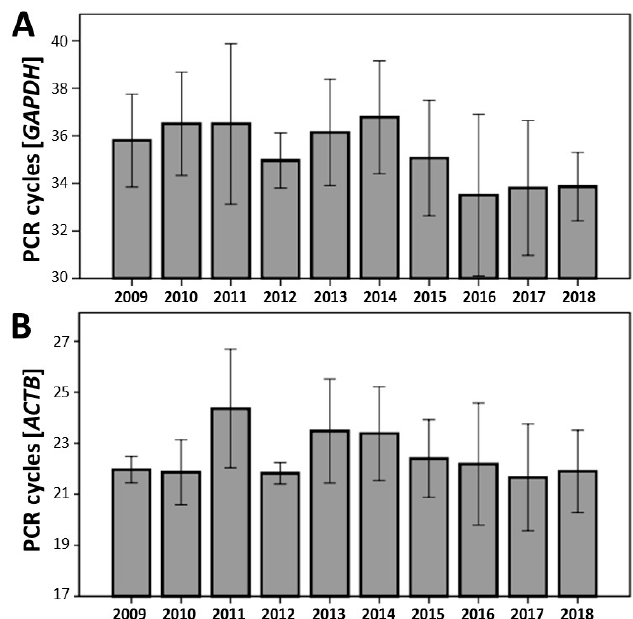
Figure 6. Results of qRT-PCR analysis from FFPE vascular tissue samples from different years between 2009 and 2018 ( n = 5 for each study group) using TaqMan primer for glyceraldehyde 3-phosphate dehydrogenase ( A , GAPDH , 130 bp) and beta-actin ( B , ACTB , 63 bp). No significant differences were observed between the individual years over time.